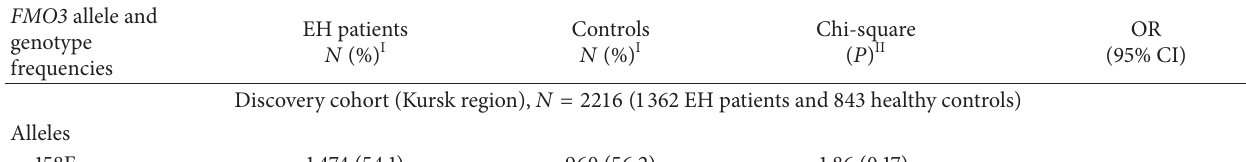
EH patients 𝑁 (%) I